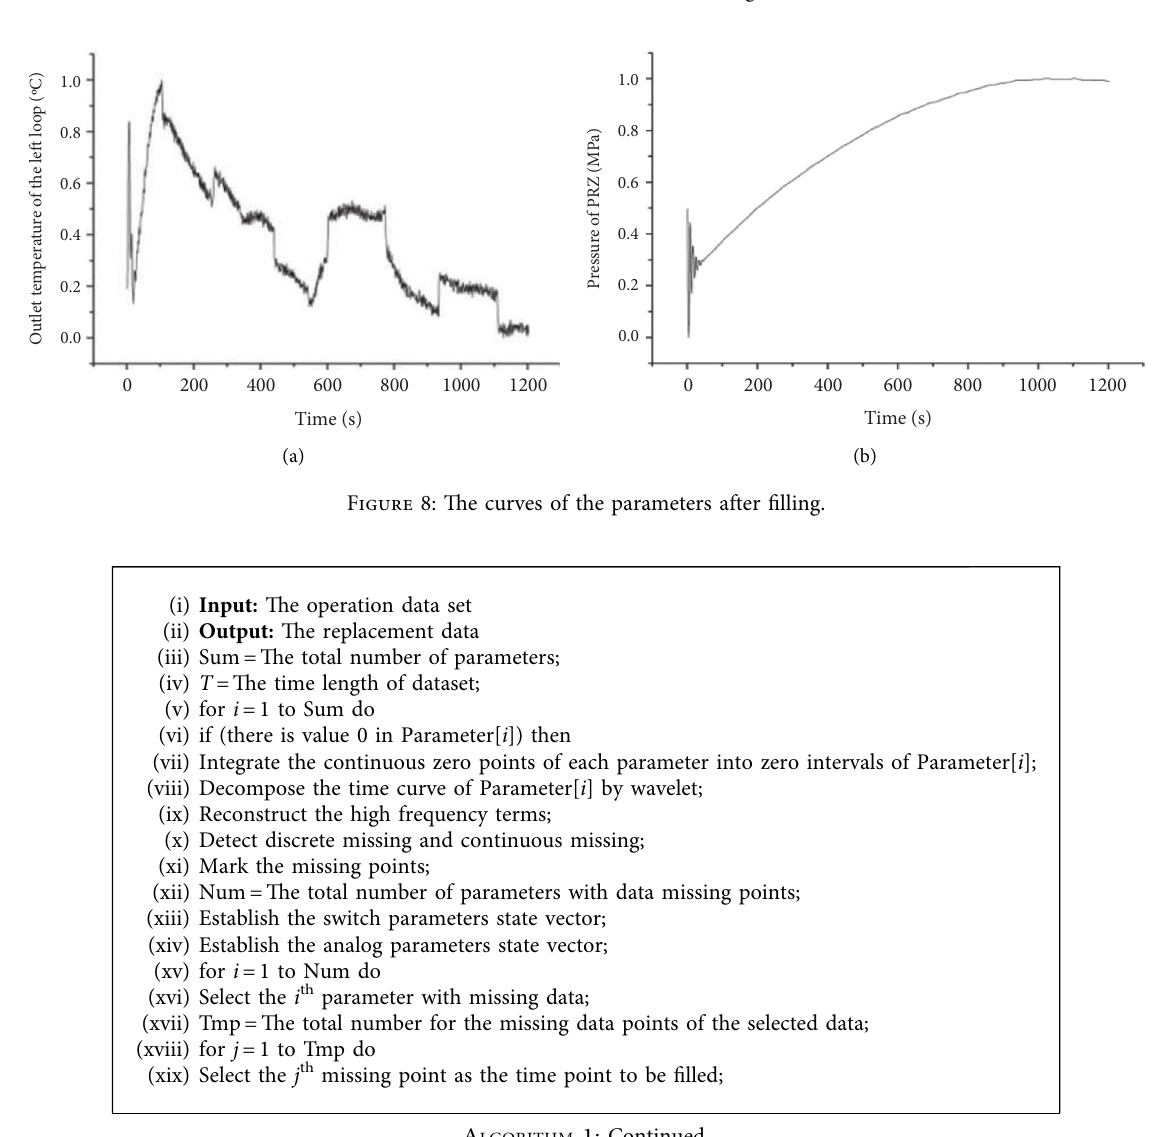
Figure 7: Detection results of the missing data.